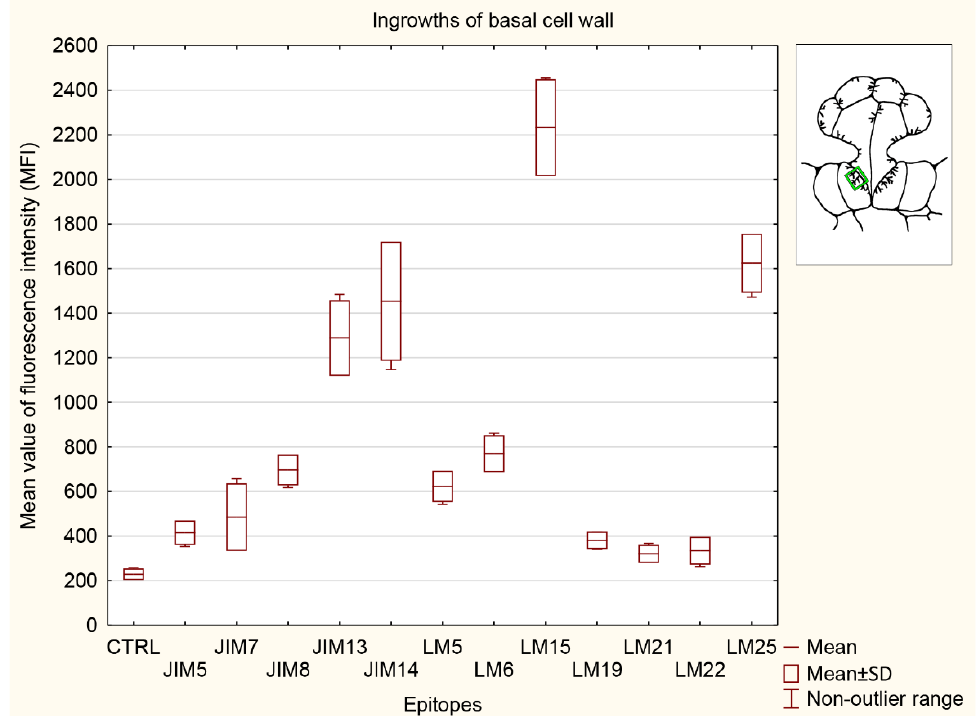
Figure 10. Quantification of immunofluorescence labeling for ingrowths of basal cell wall. Mean values of AGP fluorescence intensity (MFI) for negative control reaction (CTRL) and for labeled AGPs (JIM14, JIM8, and JIM13 epitopes), pectins (JIM5, JIM7, LM5, LM6, and LM19 epitopes), hemicelluloses (LM 15 and LM25 epitopes), and heteromannans (LM21 and LM22 epitopes) in 3 glands from 3 different traps (n = 3).